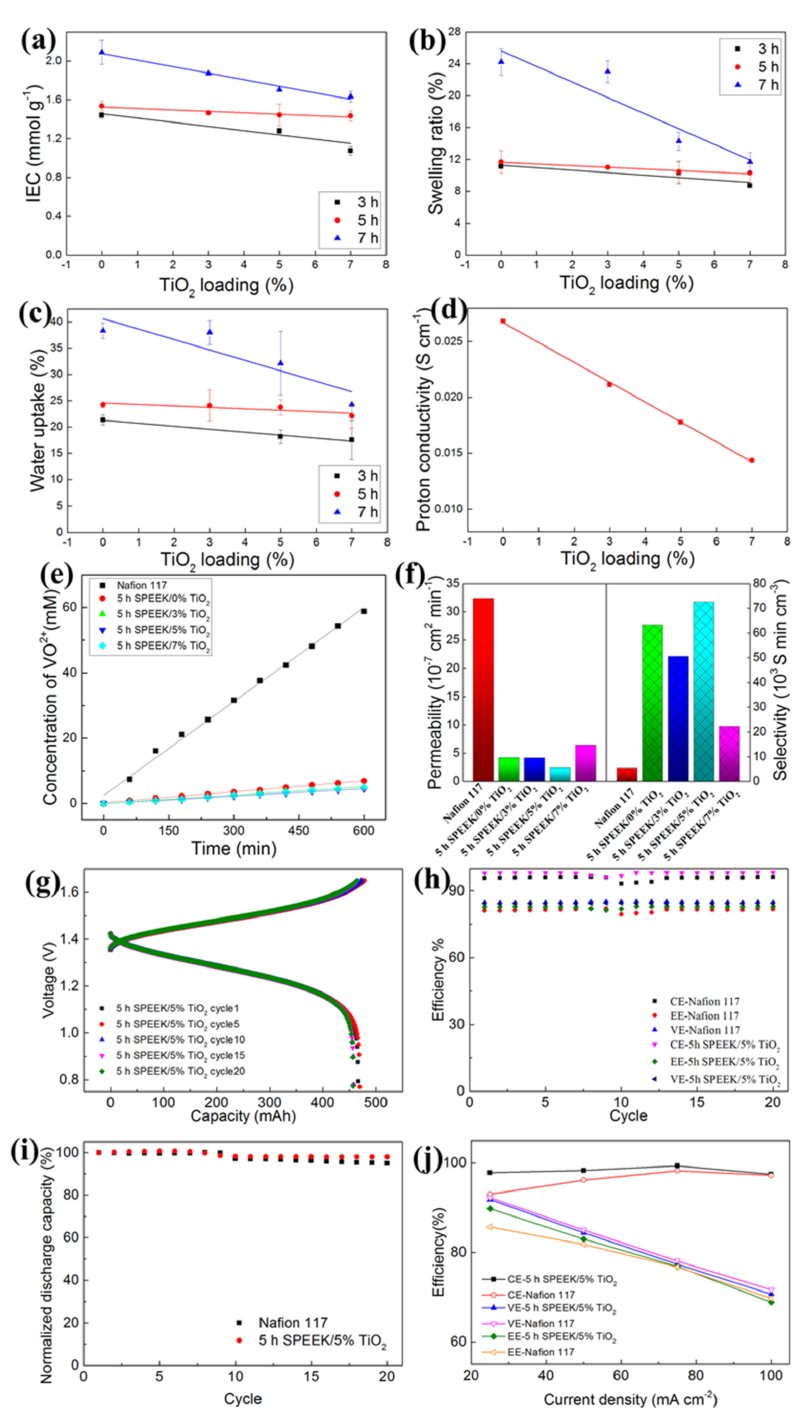
Figure 4. Different DS and amount of TiO 2 nanoparticles in sPEEK/TiO 2 composite